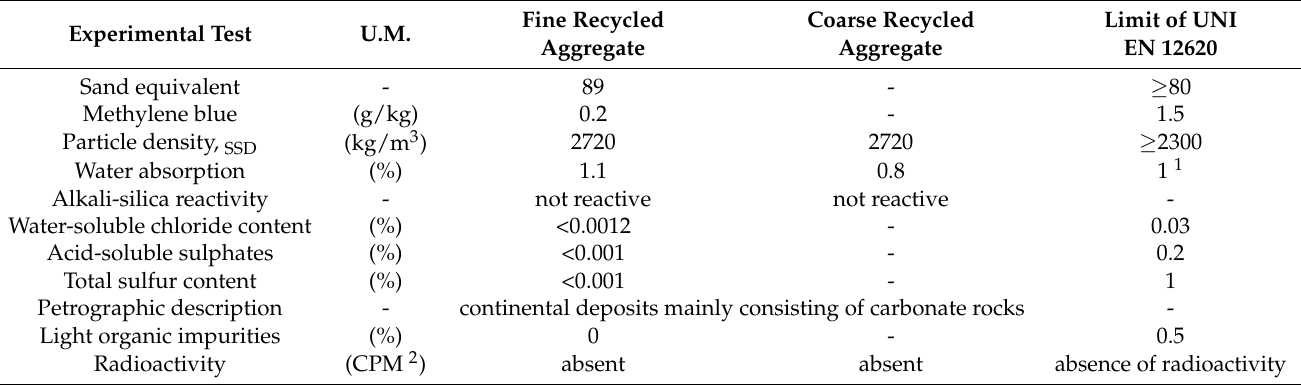
Table 3. Results of the experimental tests carried out on fine and coarse recycled aggregates.